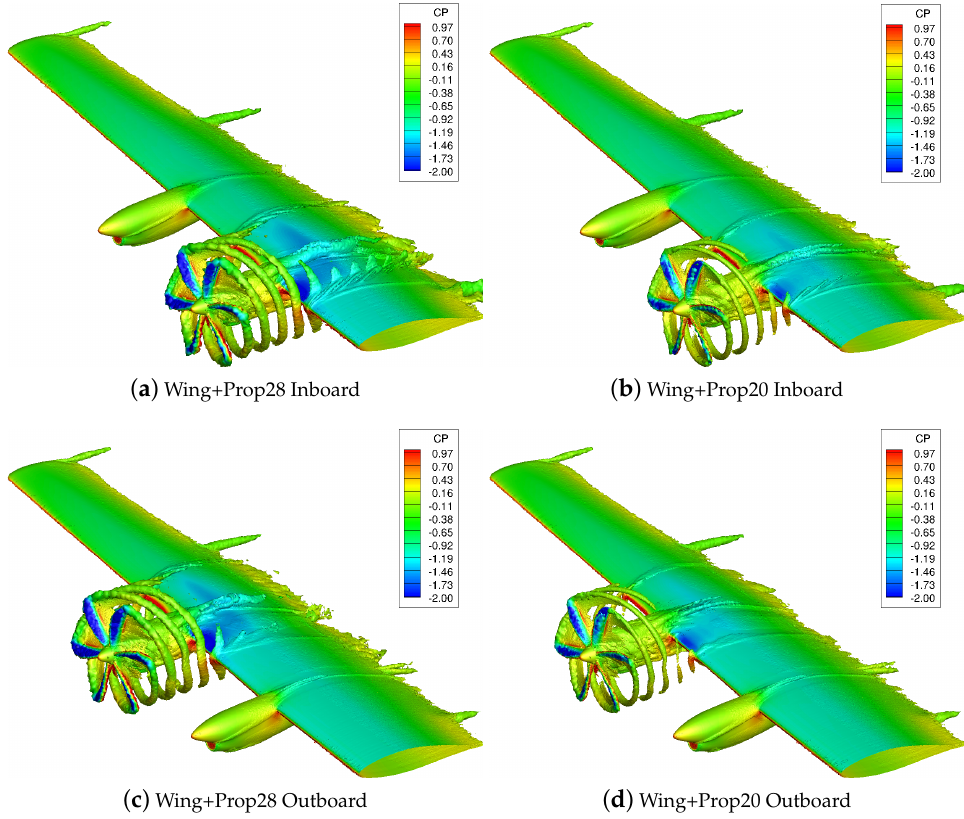
Figure 10. Propeller installed inboard/outboard; vorticity isosurfaces are colored with a pressure coefficient. Propellers have a 20-deg blade angle and spin at 1024 rpm counterclockwise. The wing only solution is time-averaged for the final three seconds of simulations. Wing+Prop solutions are at the final simulation